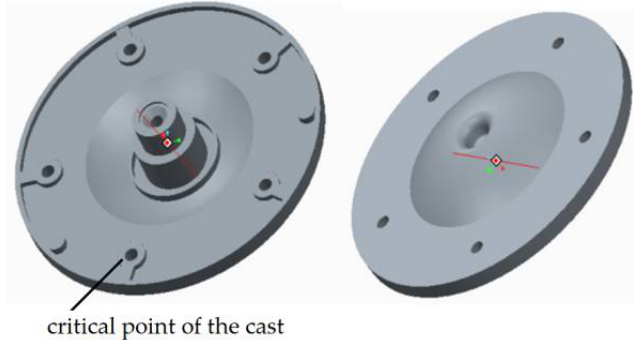
Figure 3. 3D model of electric motor flange.